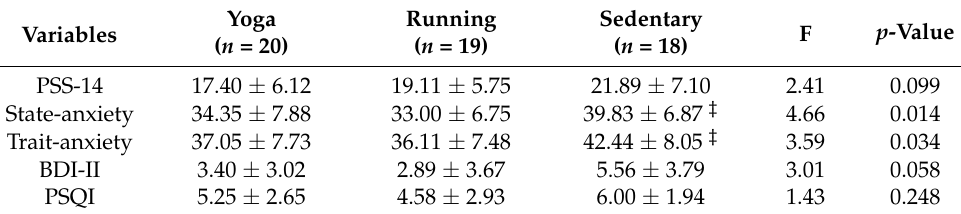
Table 2. Psychological